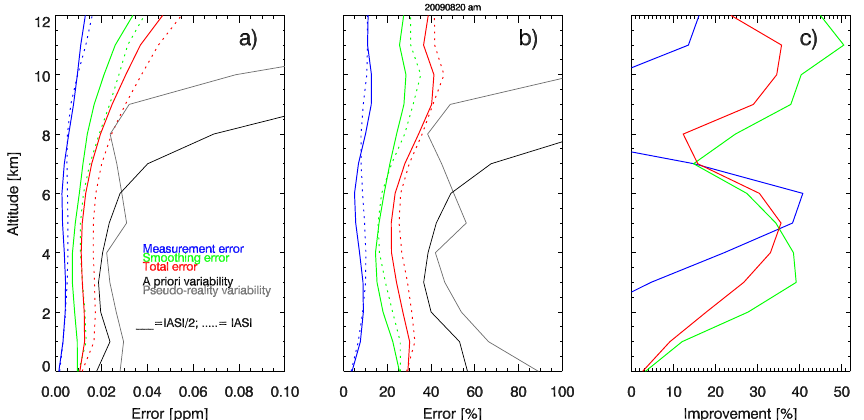
Fig. 1. Mean values for 20 August 2009, AM overpasses, of the estimated measurement (blue), smoothing (green) and total error (red), for IASI (dotted lines) and IASI/2 (solid lines): (a) absolute errors, (b) percent errors, (c) percent improvement of IASI/2 over IASI. A priori (black line) and pseudo-reality variability (grey line) are also shown.